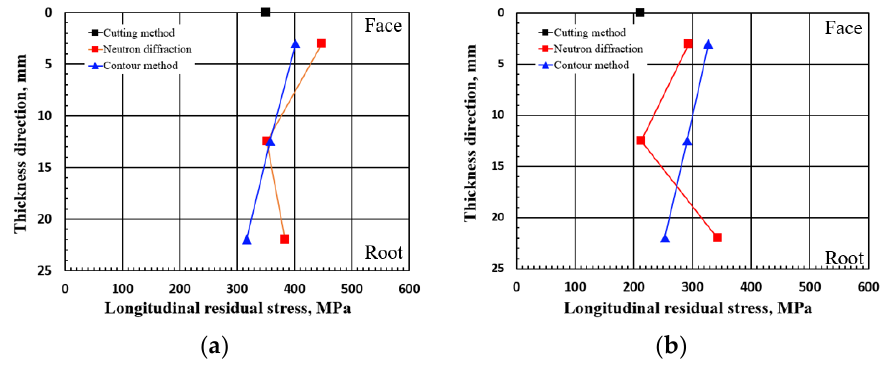
Figure 11. Weld residual stress σ x of unconstrained specimen using cutting, neutron diffraction, and contour methods. ( a ) Weld metal; ( b ) fusion line + 1 mm.